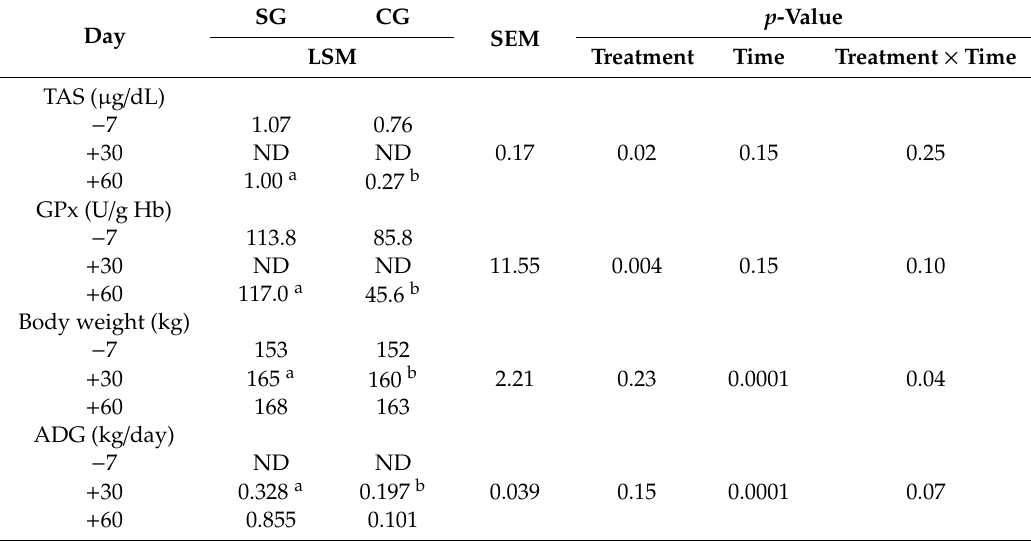
Table 1. Total antioxidant status, glutathione peroxidase activity, body weight and average weight gain in weaned calves supplemented with minerals and vitamins or sterile saline